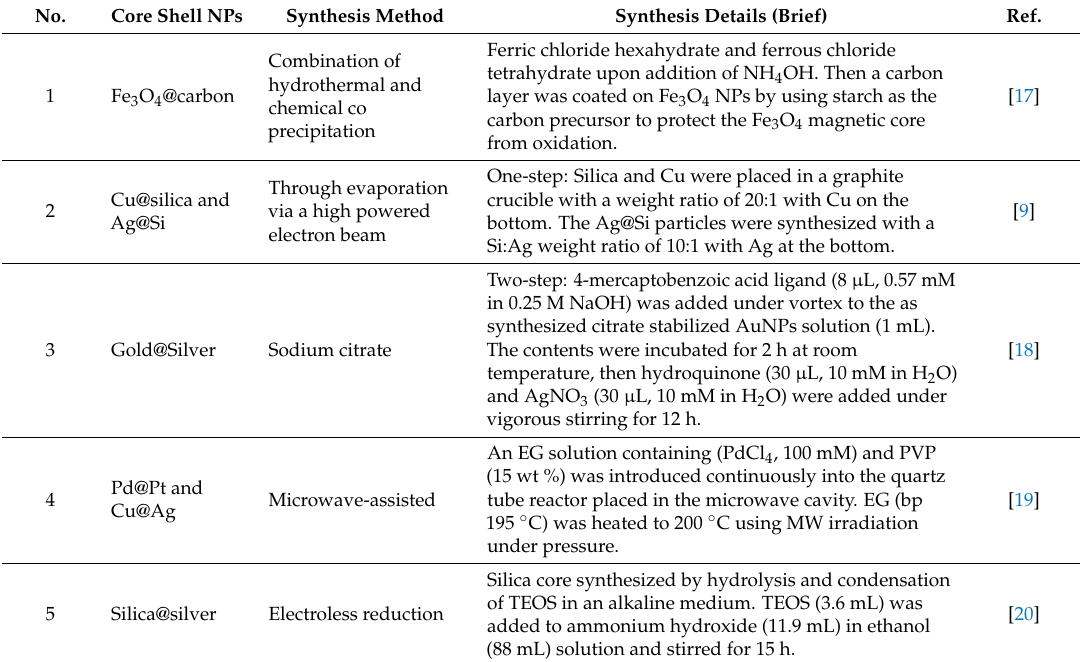
Table 1. Some examples of chemical and physical synthesis for core shell